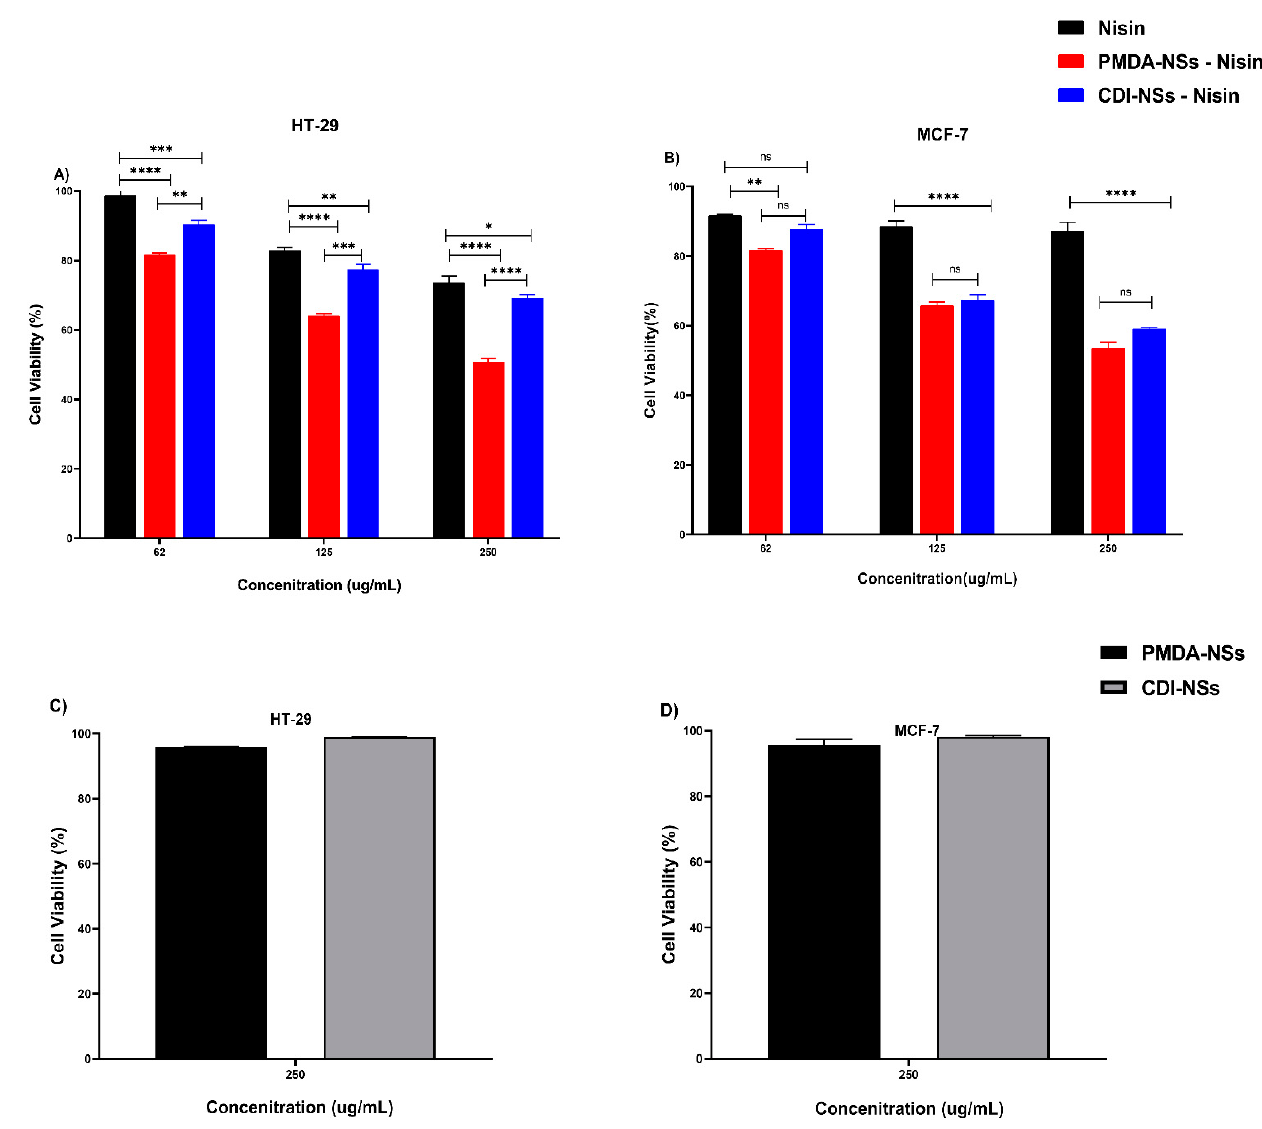
Figure 6. Cell viability results for colon cancer (HT-29) and breast cancer (MCF-7) cells exposed to Nisin-Z and loaded on nanosponges ( A , B ) and plain nanosponges ( C , D ) for 24 h. Results are expressed relative to the untreated control, which was set as 100% viable. Data are expressed as mean ± SD ( n = 3). Two-way ANOVA analyses was used. * p < 0.05, ** p < 0.01, *** p < 0.001, **** p < 0.0001, and ns (Not Significant).